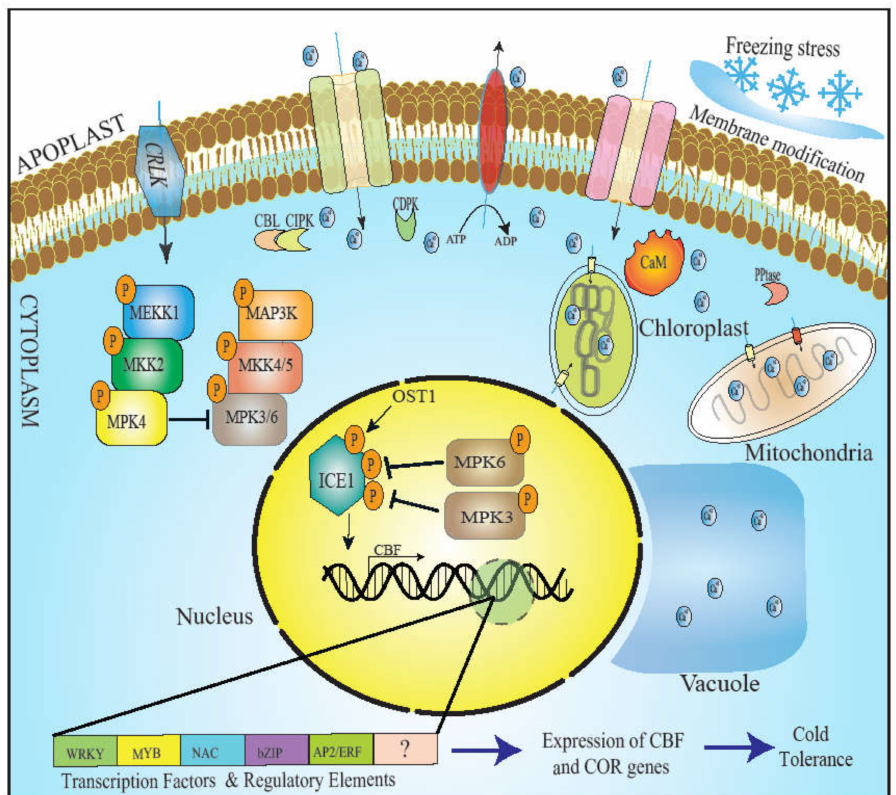
Figure 3. The schematic representation of various components involved in cold stress signaling and response. Cold stress-induced membrane modification and changes in calcium ion concentration leads to the downstream signaling events. Calcium ion signal is perceived by various calcium sensors (e.g, Calmodulin (CaM), Calcineurin B-like proteins (CBLs), CBL-interacting protein kinases (CIPKs), Calcium-dependent protein kinases (CDPKs) and CRLK present in cytosol, plasma membrane and membranes of chloroplast, mitochondria, vacuole and nucleus, etc. These signals further activate other components of cold stress response machinery such as the MAPK cascade, which ultimately regulates the expression level of ICE1, CBF, and other cold regulated gene